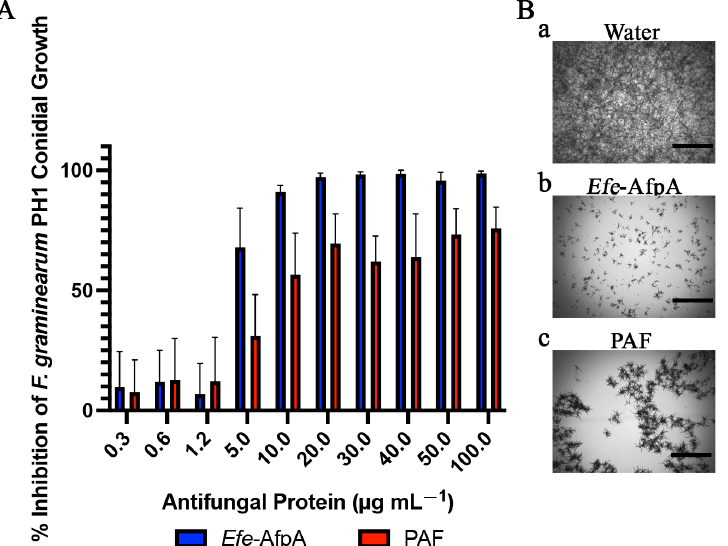
Figure 4. Activity of Efe -AfpA and PAF against F. graminearum PH1 conidial growth. ( A ) Growth inhibition of F. graminearum conidia treated with increasing concentrations of either Efe -AfpA or PAF incubated at room temperature for 30 h. The data presented are the means and standard deviations of three replicates. ( B ) Microscopy of F. graminearum conidia treated with water or 10 μ g mL − 1 of either Efe -AfpA or PAF. Bars are 750 μ m.